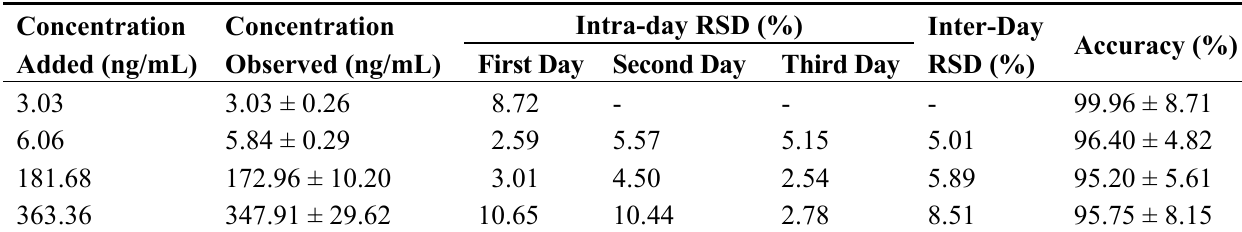
Table 1. Precision and accuracy of MP in plasma (n = 5).